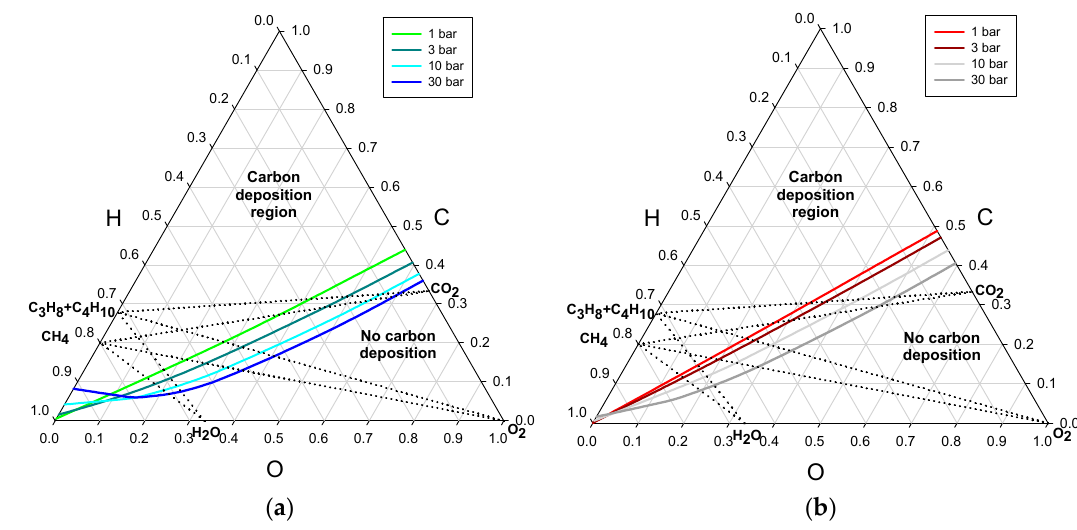
Figure 4. Deposition threshold lines for the border process pressures of 1 and 30 bar: ( a ) temperature of 800 °C; and ( b ) temperature of 1000 °C.